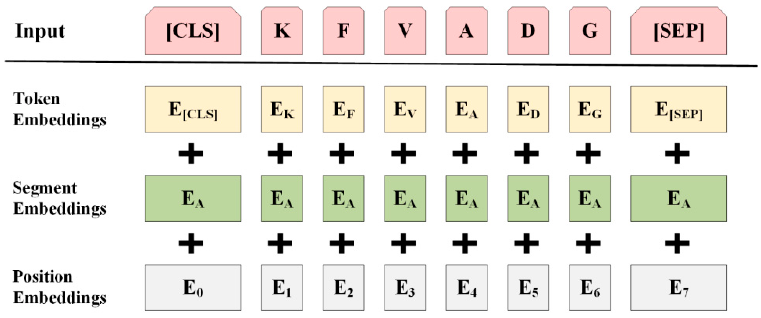
Figure 5. BERT coding representation.